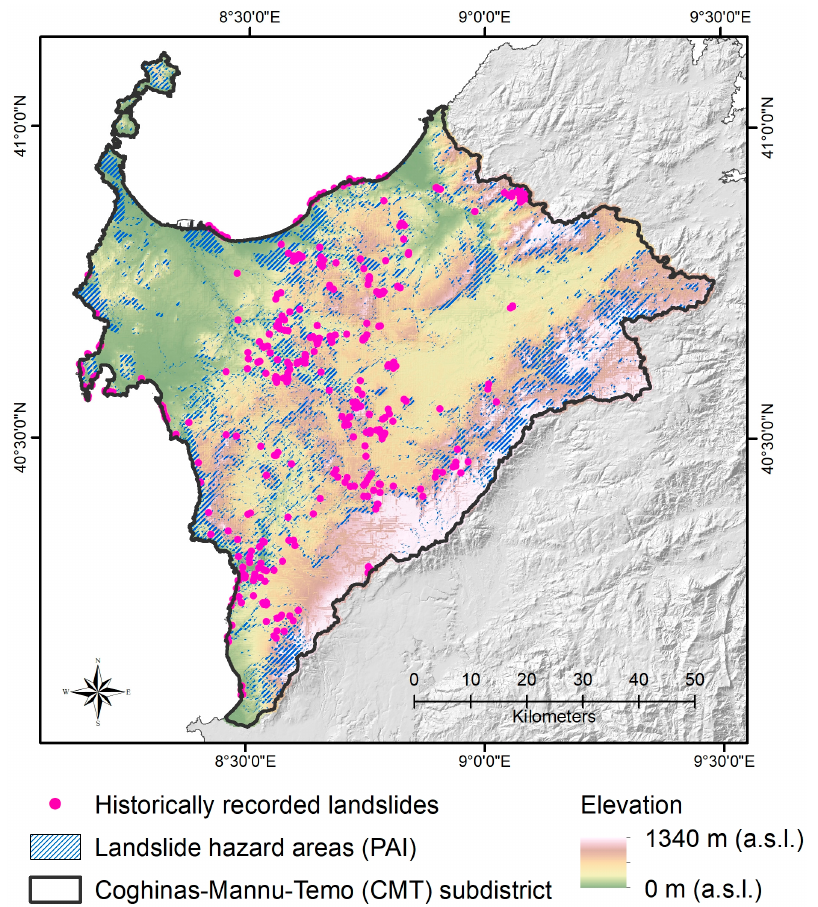
Figure 6. Spatial overlay between historically recorded landslides, landslide hazard areas mapped in the PAI, and regional DTM.